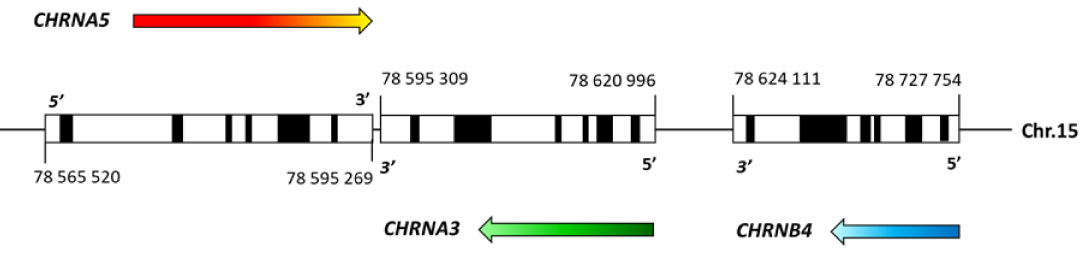
Figure 1. Diagram of the human CHRNA5 / A3/B4 gene cluster. Each gene is drawn to scale, with black boxes representing exons and white boxes representing untranslated regions. Colored arrows indicate the direction of transcription. The locations of each gene are marked. Homo sapiens chromosome 15, GRCh38.p14 Primary Assembly; NCBI Reference Sequence: NC_000015.10 (https: //www.ncbi.nlm.nih.gov/nuccore/NC_000015.10 (accessed on 15 June